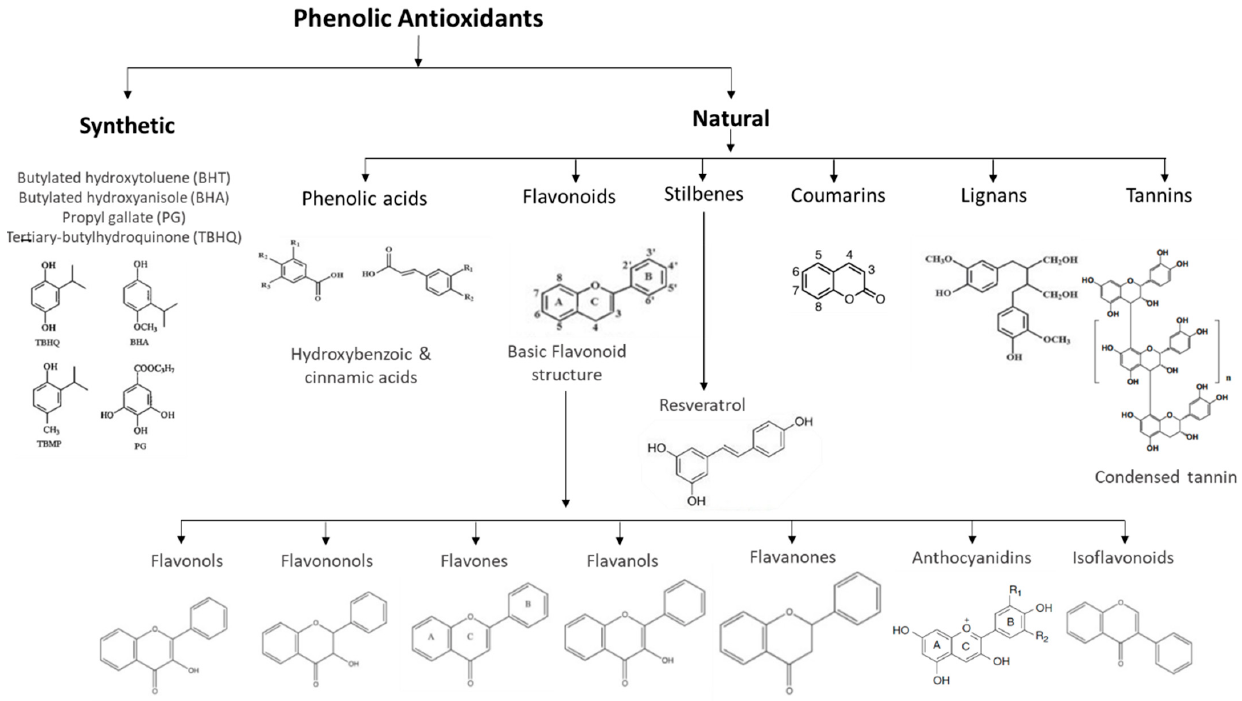
Figure 6. Phenolic antioxidants classification. Adapted from Shahidi and Ambigaipalan [53].